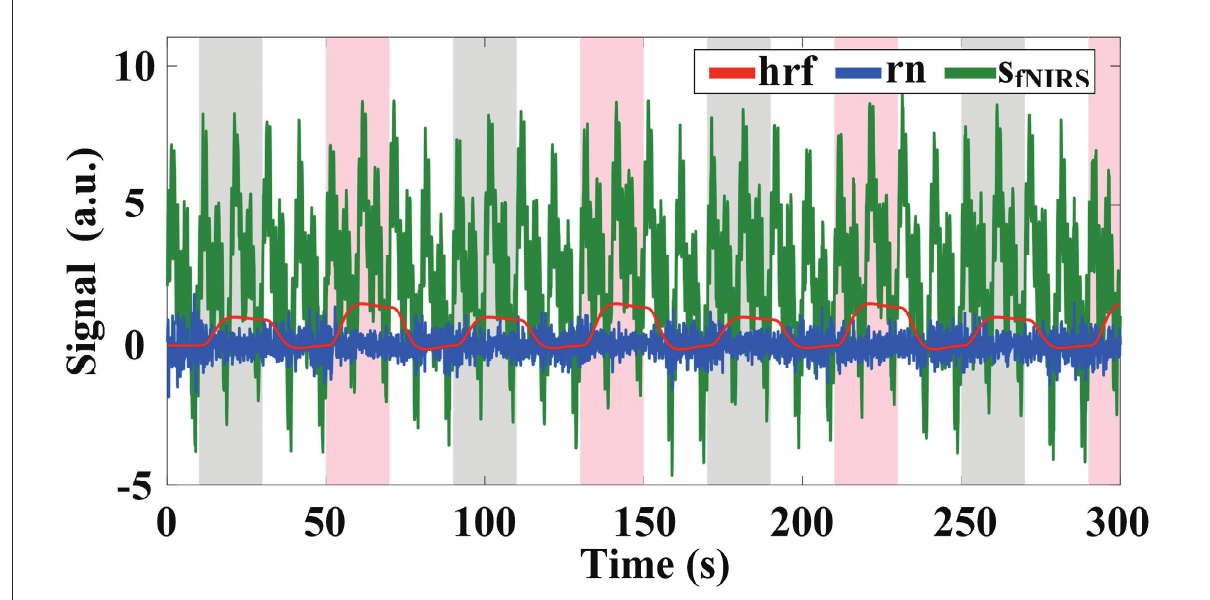
FIGURE1 Example of simulated fNIRS signal with the amplitude of the baseline set to 2, the initial amplitude of the physiological interference set to 2, and a Gaussian white noise with SNR = 10 dB. The gray and pink highlighted rectangles indicate stimulation periods for task 1 and task 2,